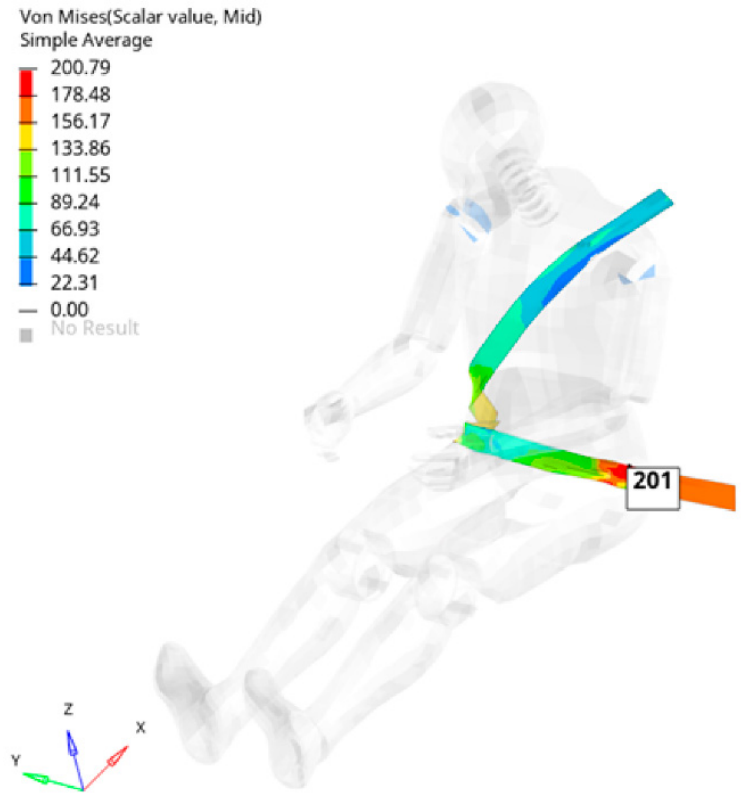
Figure 15. Stress in the belt when T = 0.050 s (in MPa).